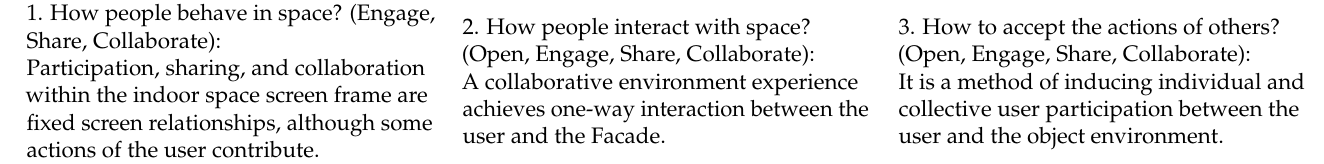
Table 2. Case study by type of media-interaction space: media case analysis in a user participatory public play space. User Engagement Media Interaction Media-User Interaction Space Type